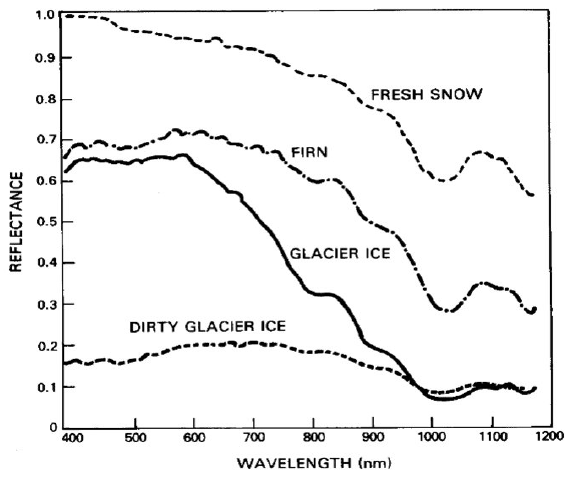
Fig. 2. The spectral dependency of snow and ice depending on their formation stage (Zeng et al.,